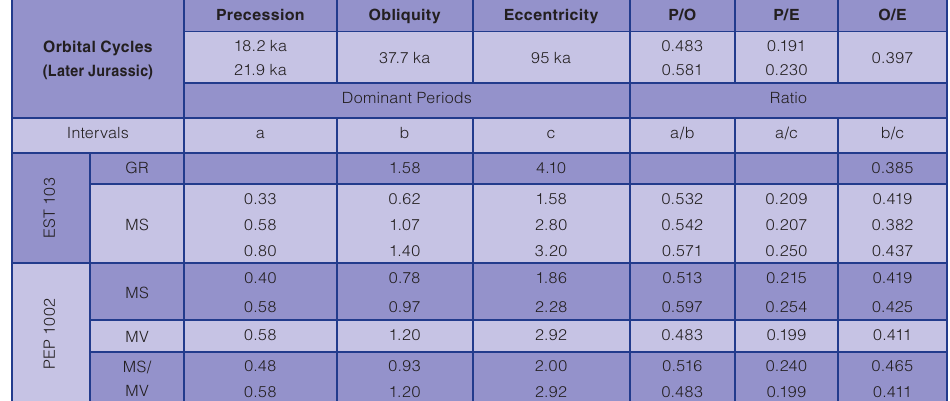
Table 1. Durations and duration ratios of orbital cycles, defined for the Late Jurassic (Berger and Loutre, 1994), frequency ratios of the principal cycles observed in MS and GR recording spectra from the EST 103 hole, and of the principal cycles observed in MS, MV and MS/MV recording spectra from the PEP 1002